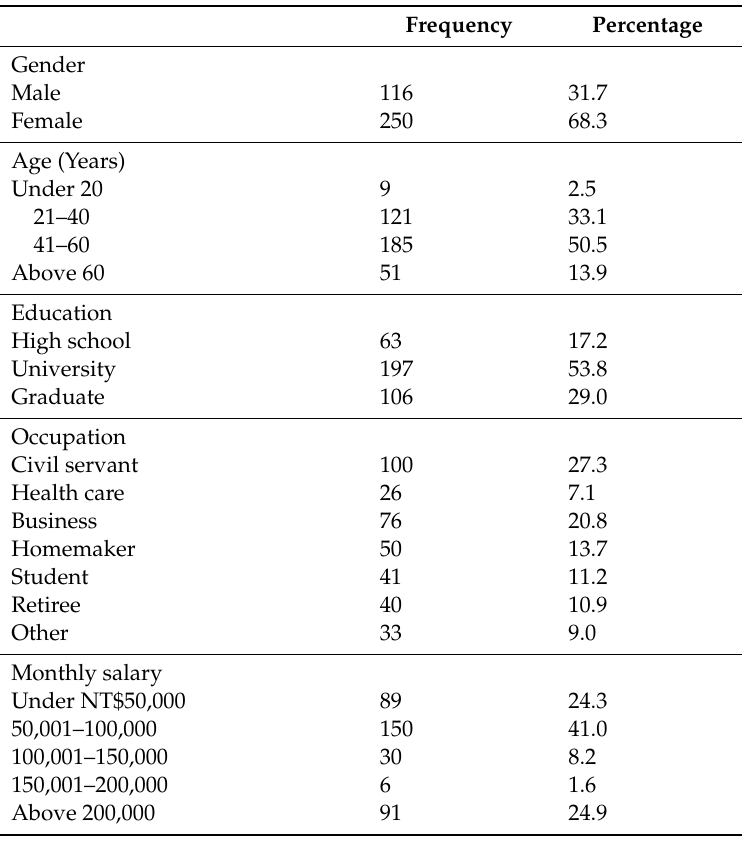
Table 1. Characteristics of the respondents (N =